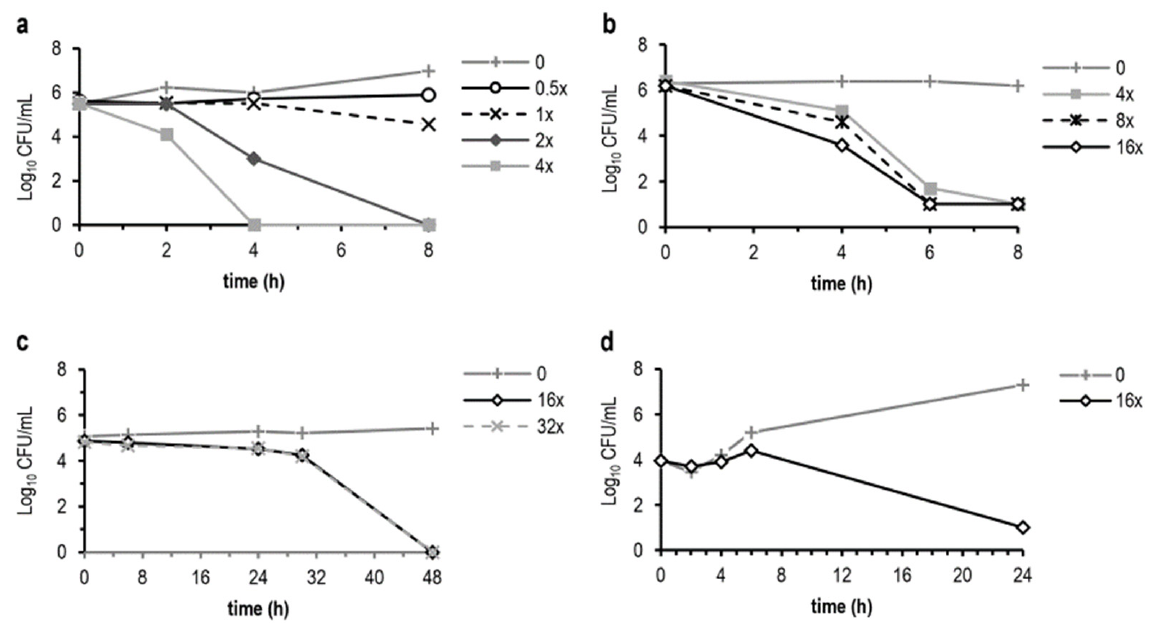
Figure 2. Representative kill curves at multiples of the MICi for NPBD against ( a ) Candida albicans (ATCC 10231) in SLM at 37 °C, ( b ) C. albicans in distilled water at room temperature, ( c ) Aspergillus fumigatus (RMIT 702/1-1) hyphae and ( d ) microconidia in distilled water at room temperature.